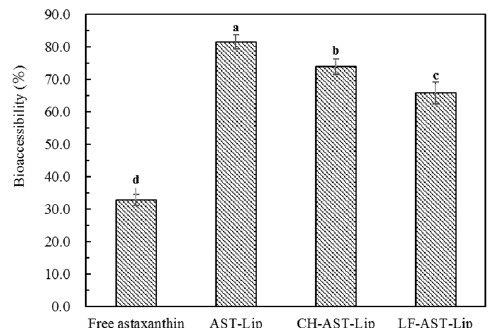
Figure 8. Bioaccessibility of different samples. Different lowercase letters indicate significant differences between groups ( p < 0.05).